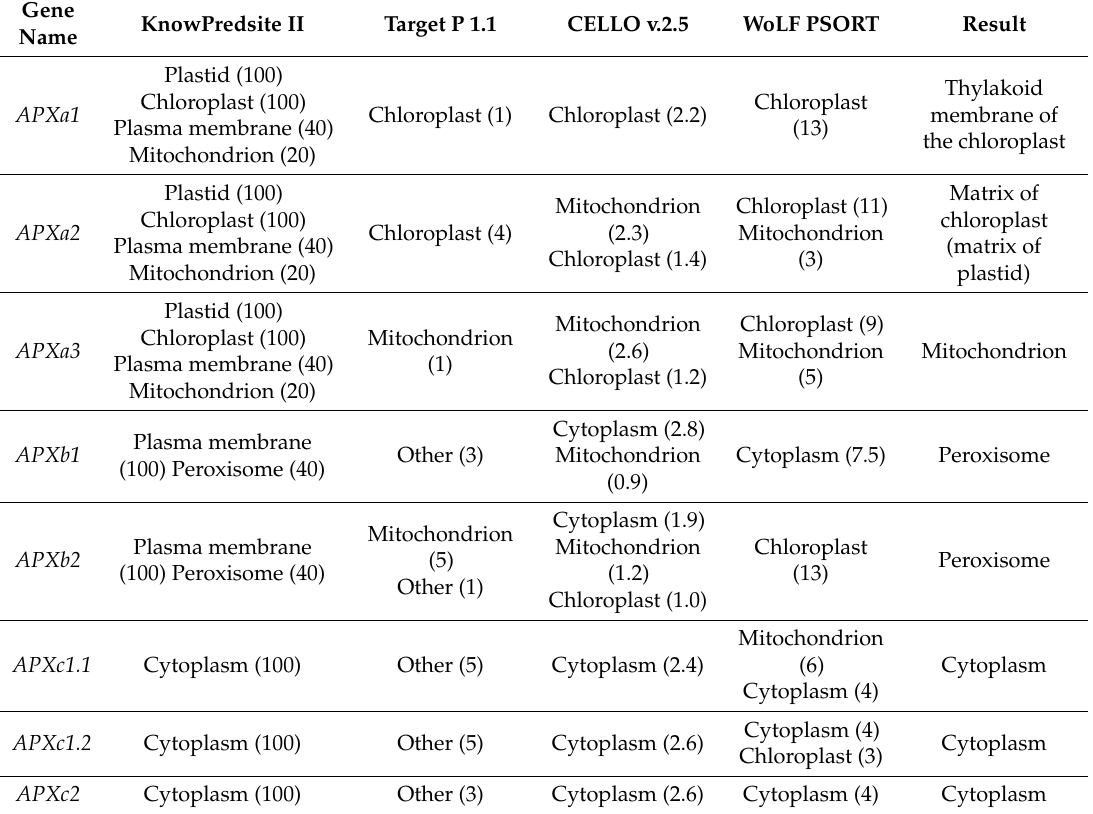
Table 1. Predicted subcellular localization of maize APX